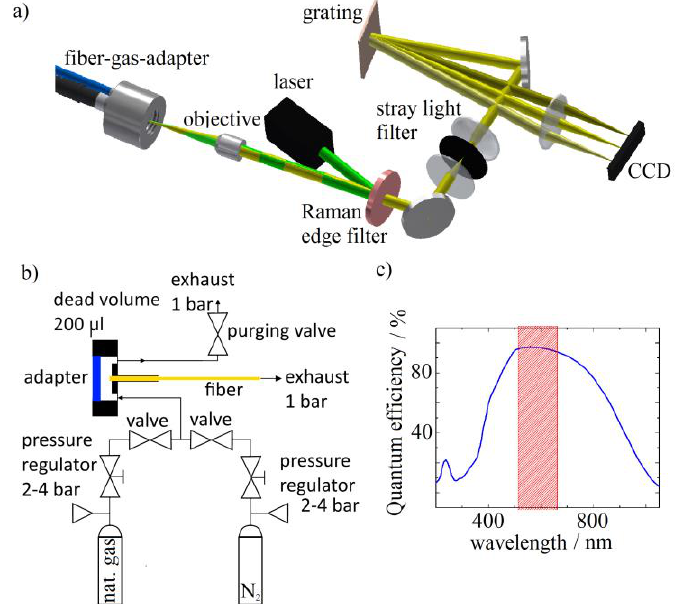
Figure 2. ( a ) Schematic drawing of the setup. The excitation light is depicted in green and the Raman-scattered in yellow; ( b ) Plumbing diagram for the gas delivering system with the hollow fiber (yellow); ( c ) Quantum efficiency of the Andor iDus401-BVF camera. The red-shaded region marks the spectral range used.